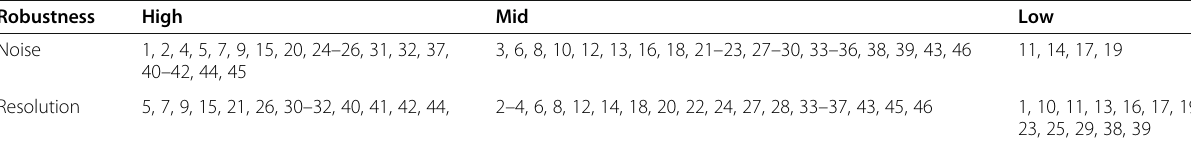
Table 3 Robustness of texture features as a function of noise and resolution